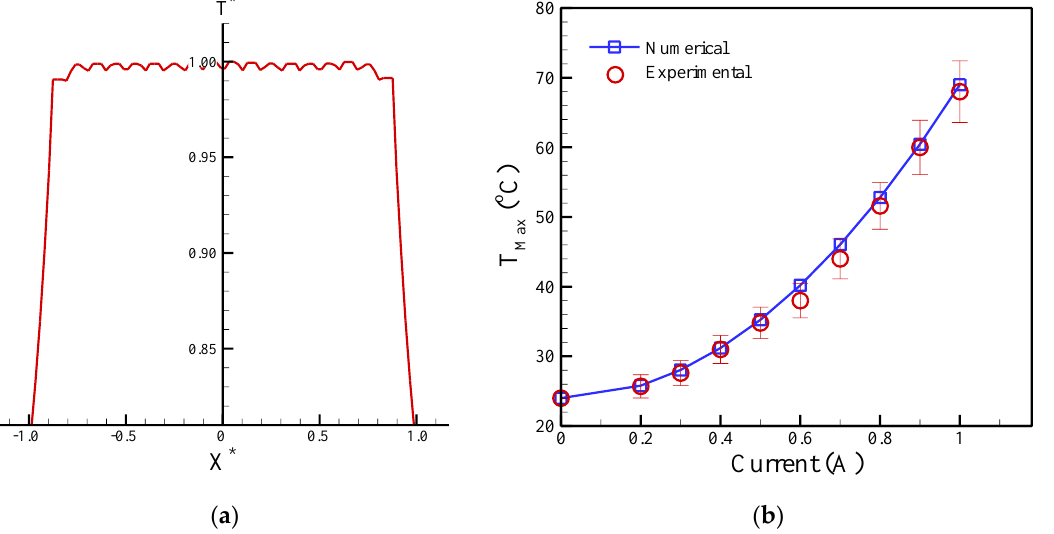
Figure 8. ( a ) Numerical profiles of T* varied along with the dimensionless distance of x*. ( b ) Numerical and experimental comparison of maximum temperature ( T Max ) versus different applied currents.